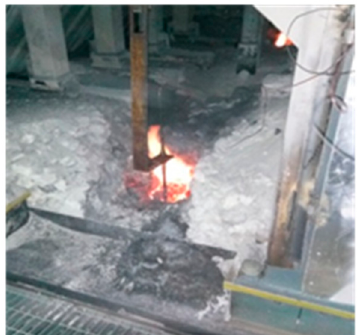
Figure 4. Thermocouple location.